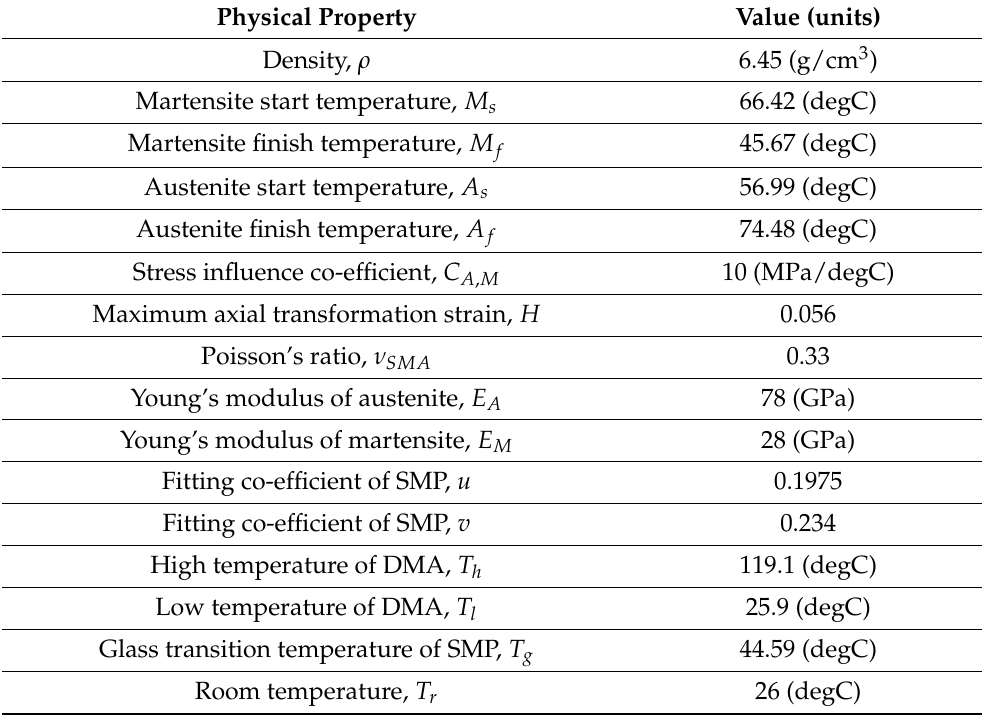
Table 2. Model parameters required for setting up the COMSOL Multiphysics simulation: NiTi SMA [22] parameters with DSC testing data and SMP thermal transport properties [14] with phase transformation parameters from DMA testing